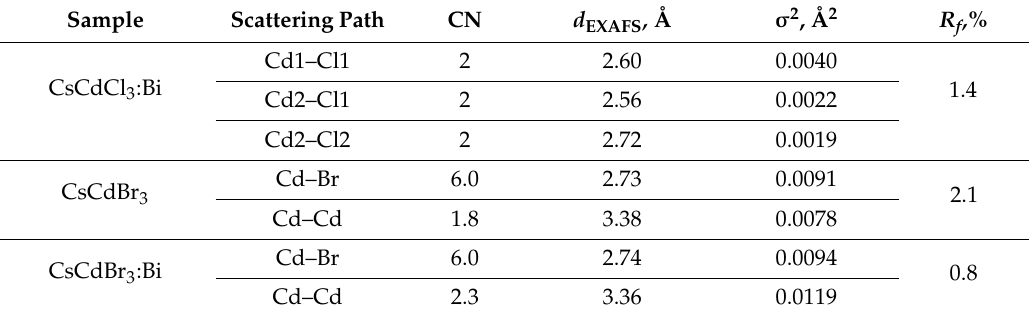
Table 10. Results of EXAFS fit at the Cd K-edge for the CsCdBr 3 , CsCdBr 3 :Bi and CsCdCl 3 :Bi crystals: coordination number, CN; interatomic distance between the central atom and the next neighbors (the length for single scattering path), d , Å; the Debye–Waller factor, σ 2 ; the convergence factor, R f .